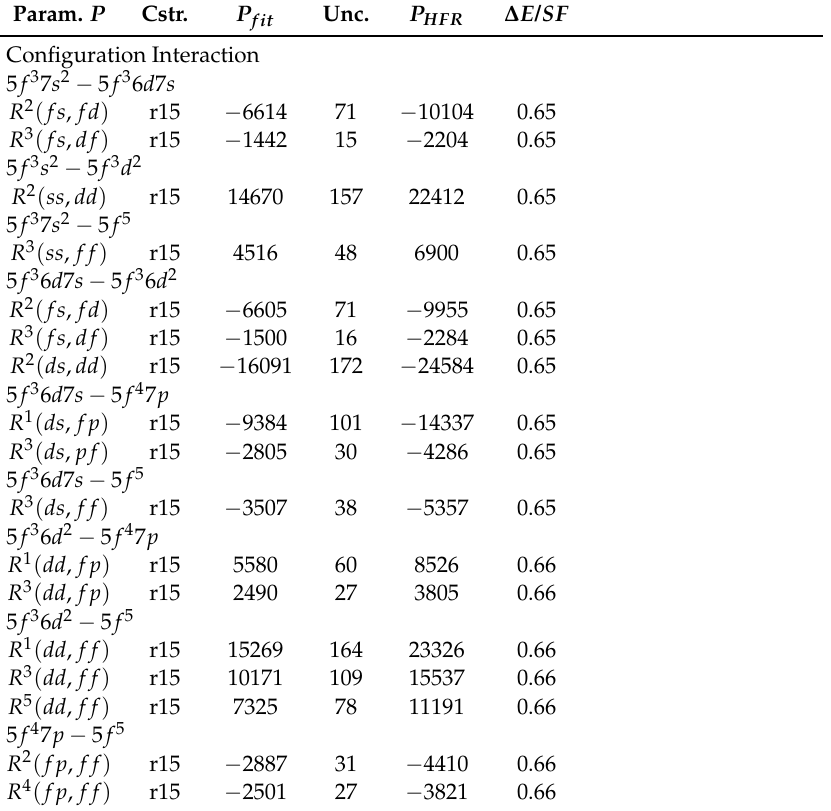
Param. P Cstr. P fit